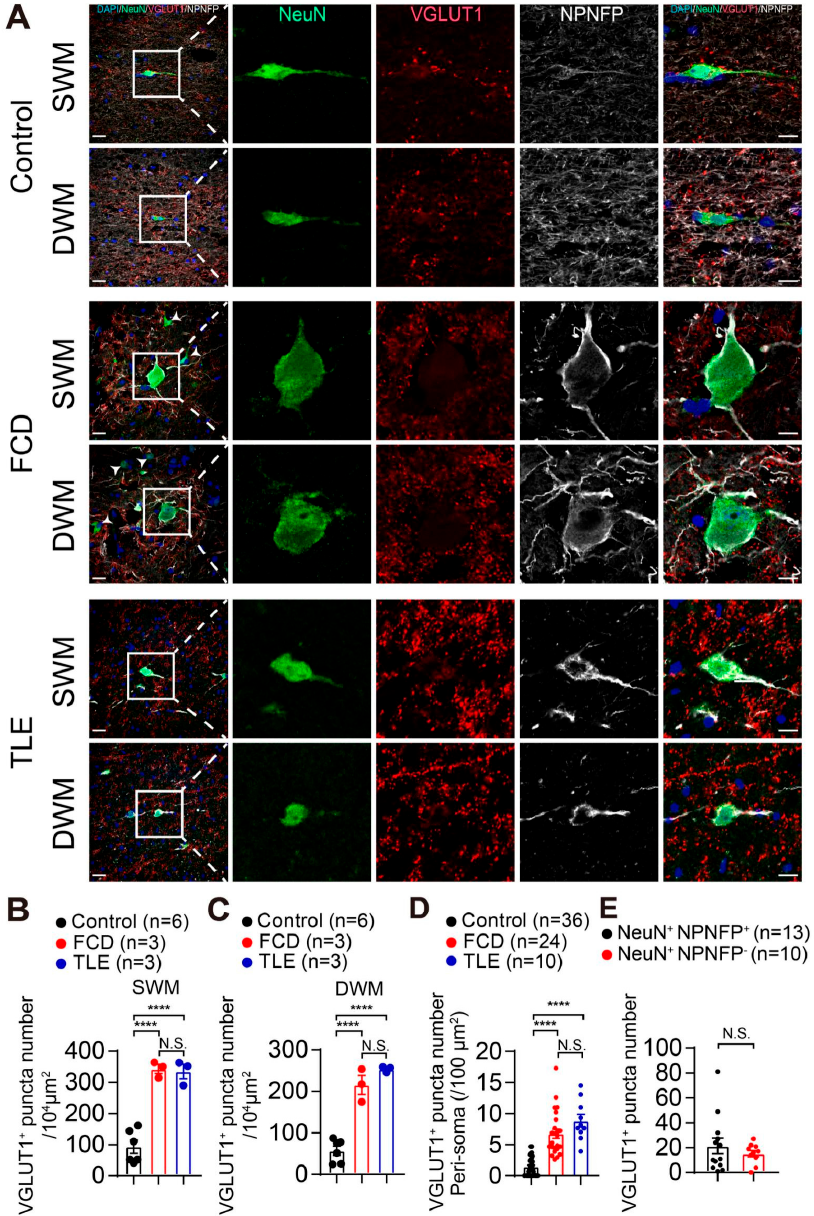
Figure 4. Increased glutamatergic synaptic density in the white ma tt er of drug-resistant epilepsy patients. ( A ) Example images showing the distribution of VGLUT1 in the peri-soma and primary dendrites of interstitial neurons in the super fi cial and deep white ma tt er of brain tissue sections from FCD, TLE and control, respectively. Scale bar, 20 µm in the original image (left) and 10 µm in zoom-in image (right). SWM: super fi cial white ma tt er; DWM: deep white ma tt er. ( B ) Statistics show- ing the density of VGLUT1 positive synaptic puncta in the super fi cial white ma tt er (SWM) (SD: control = 52.26, FCD = 25.46 and TLE = 39.68) and in the deep white ma tt er (DWM) (SD: control = 27.49, FCD = 39.51 and TLE = 7.21) ( C ) of FCD and TLE compared with control brain samples. ( D ) Statistics showing the number of VGLUT1 positive puncta distributed on the peri-soma of intersti- tial neurons of brain tissue sections from control ( n = 36 cells from 6 samples), FCD ( n = 24 cells from 3 samples) and TLE ( n = 10 cells from 3 samples) (SD: control = 1.45, FCD = 3.57 and TLE = 3.22), respectively. ( E ). Statistics showing the number of VGLUT1 positive puncta distributed in the peri- soma of NeuN + NPNFP + and NeuN + NPNFP - interstitial neurons of brain tissue sections from FCD and TLE (SD: NeuN + NPNFP + = 22.71, NeuN + NPNFP - = 6.60). Data are presented as mean ± SEM. **** p < 0.0001, N.S., no signi fi cance. One-way ANOVA with Tukey’s multiple comparisons test.